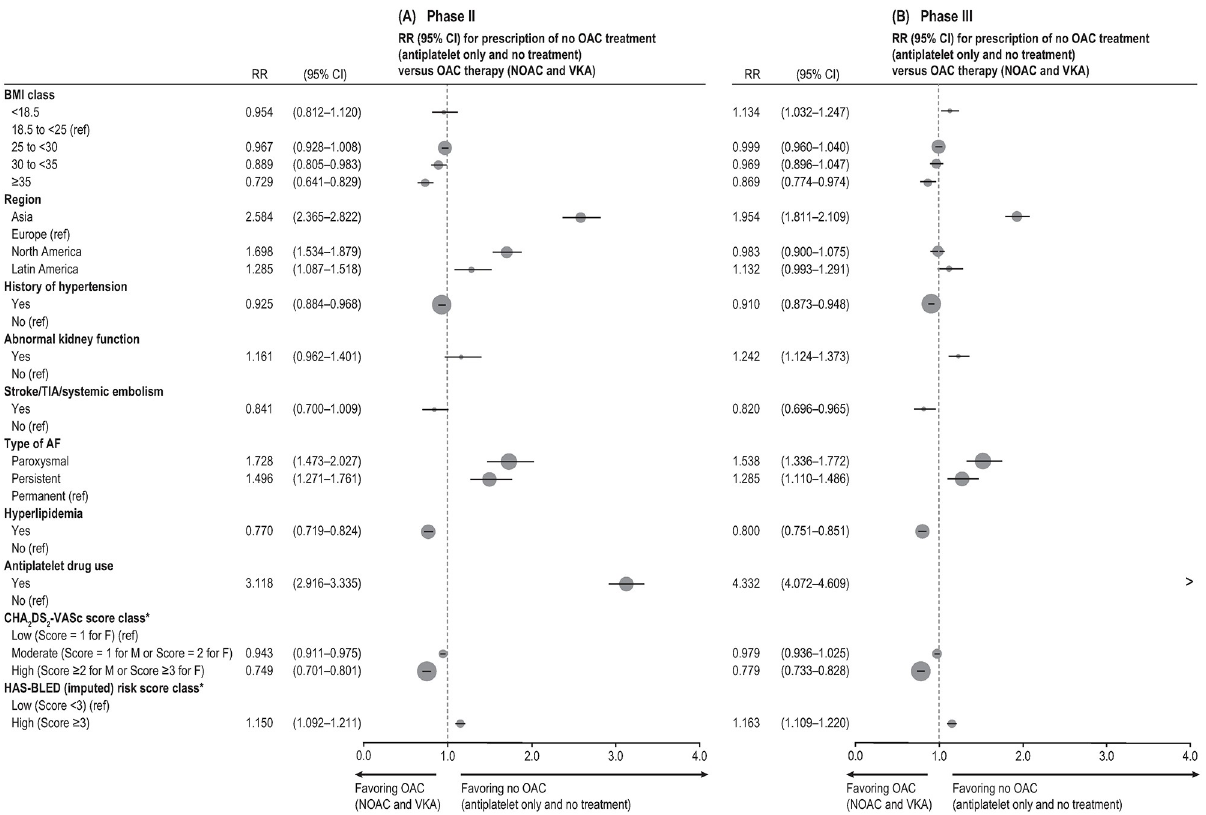
Fig 1. Factors most strongly associated with prescription of no OAC treatment (AP only and no treatment) versus OAC therapy (NOAC and VKA) in phase II (A) and phase III (B). AF, atrial fibrillation; BMI, body mass index; CHA 2 DS 2 − VASc (congestive heart failure, hypertension, age � 75 years, diabetes, stroke/transient ischemic attack/systemic embolism, vascular disease, age from 65–74 years, sex category [female]); CI, confidence interval; F, female; HAS-BLED (hypertension, abnormal renal/liver function, stroke, bleeding history or predisposition, labile international normalized ratio, elderly [ > 65 years], drugs or alcohol concomitantly); M, male; NOAC, novel/nonvitamin K oral anticoagulants; OAC, oral anticoagulation; ref, reference; RR, relative risk; TIA, transient ischemic attack; VKA, vitamin K antagonist. � Effect estimates obtained from the model including all variables of interest and the risk scores, but not the components of the risk